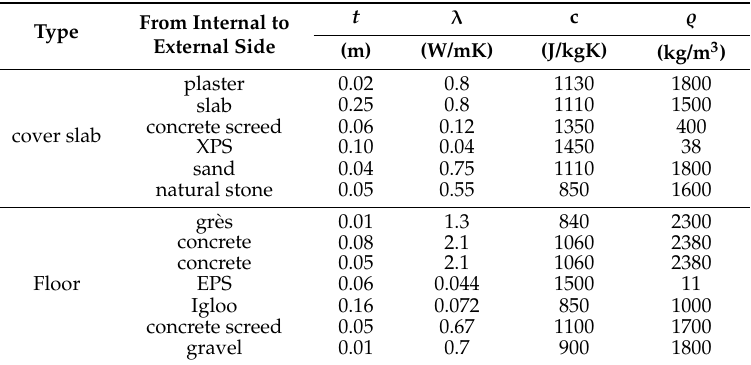
Table 3. Slab and floor stratigraphy.